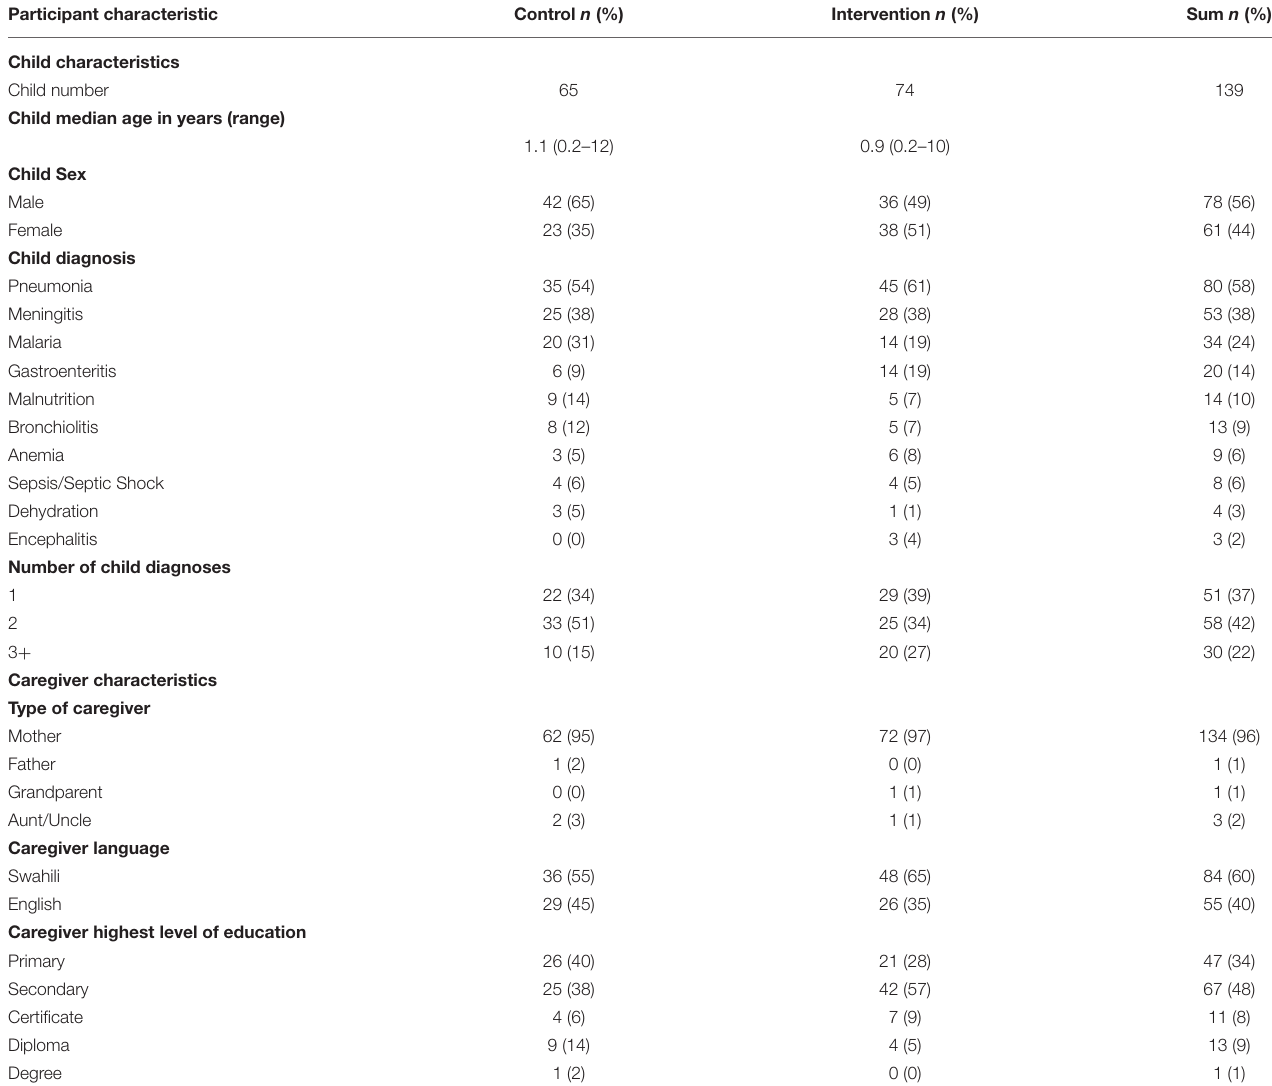
TABLE 1 | Demographic and clinical characteristics of patient/caregiver pairs. Participant